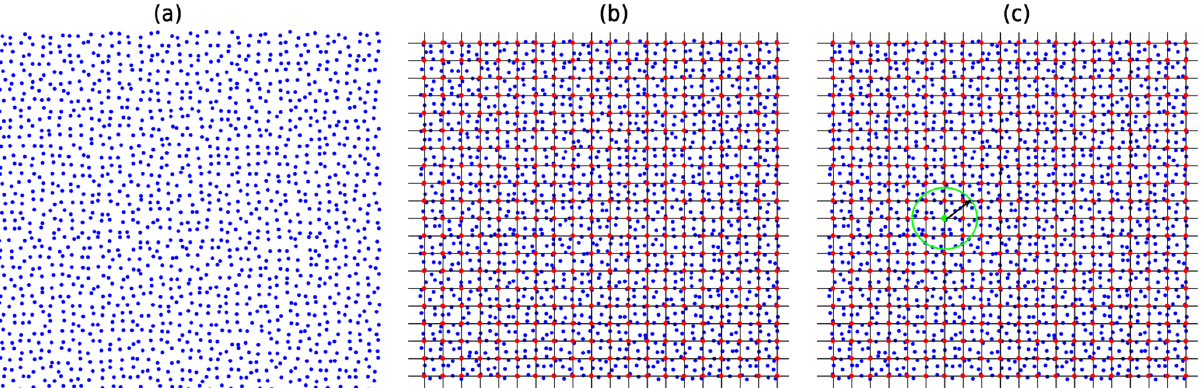
Figure A1. Procedure of projection of simulation results carried by particles onto regular grids, as shown in these figures from left to right: (a) raw data of SPH simulation results (irregularly distributed in space), (b) addition of a regular mesh and (c) searching for neighbors of each node (the blue SPH particles within the green circle around the red dot). The last step is not shown in these pictures, which treats each node on the regular mesh as a SPH particle and projects data on particles onto nodes utilizing SPH interpolation (see Eq.